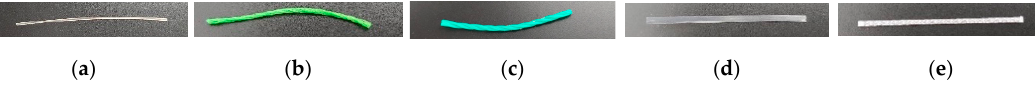
Figure 3. Geometry of the WFN fibers and CP fibers: ( a ) WFN1; ( b ) WFN2; ( c ) WFN3; ( d ) CP1; ( e ) CP2. WFN, waste fishing net; CP, commercial polypropylene.